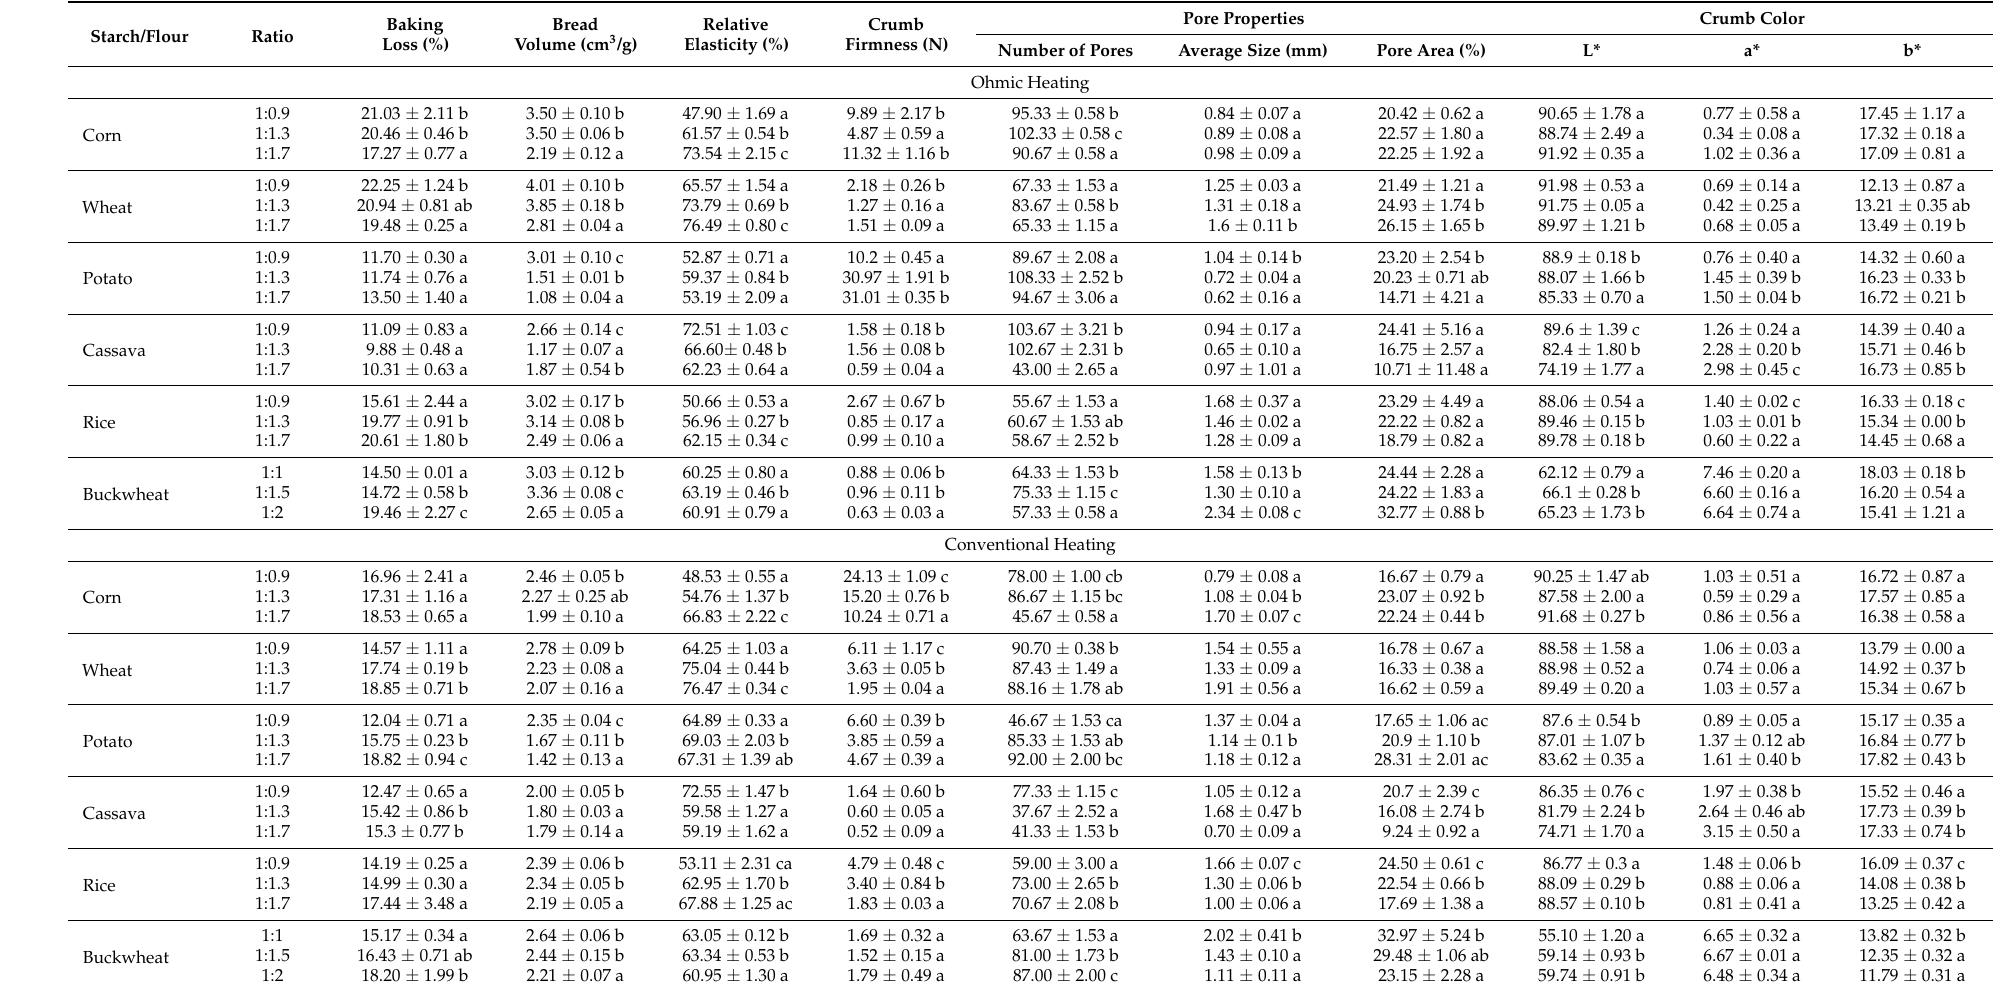
Table 4. GF bread properties of ohmic and conventionally baked